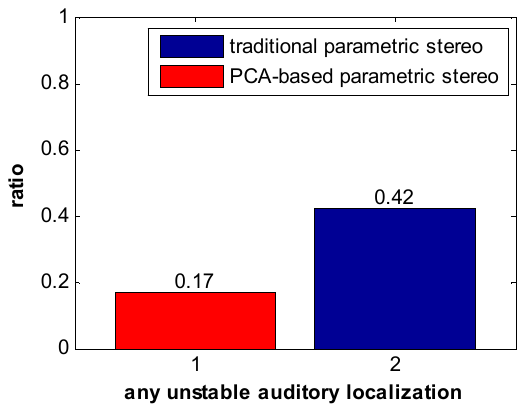
Figure 16. Test results for spatial sense.